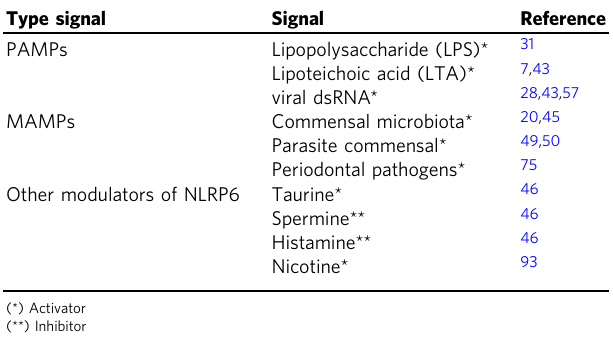
Table 1 Modulators of NLRP6 in fl